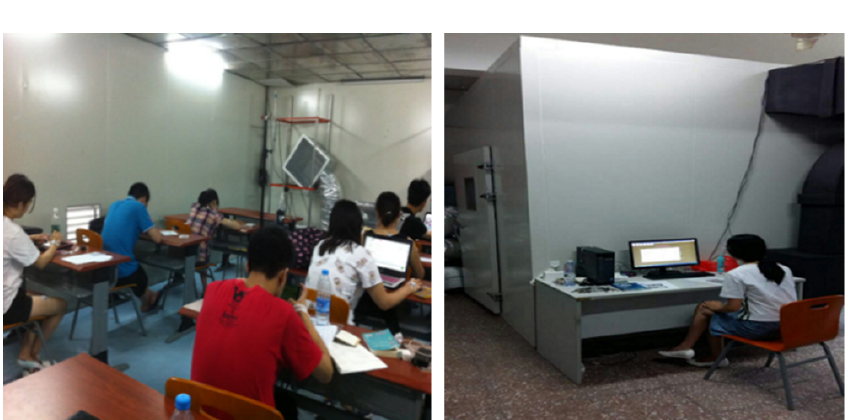
Figure 5. Internal and external view of the experimental chamber